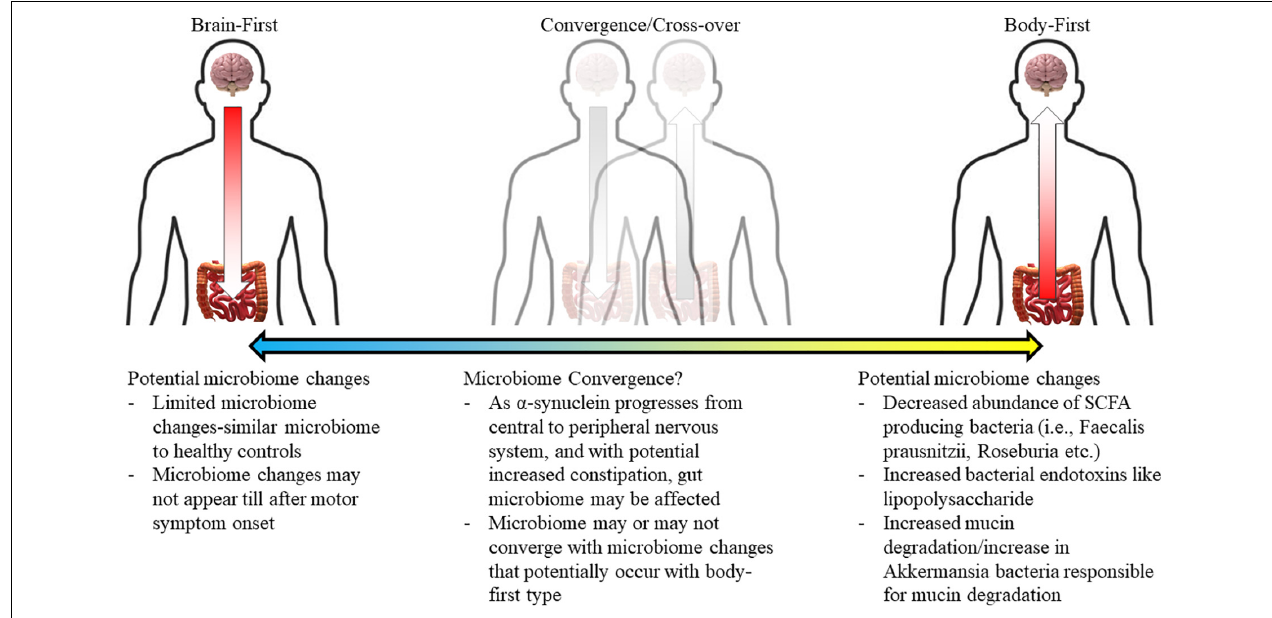
FIGURE 1 | Authors’ purported hypothesis of different gut microbiomes existing for each of the brain- and body-first phenotypes. Microbiome changes are hypothesized to converge between the two phenotypes as disease progresses in each. Additionally, this is likely to occur across a gradient.